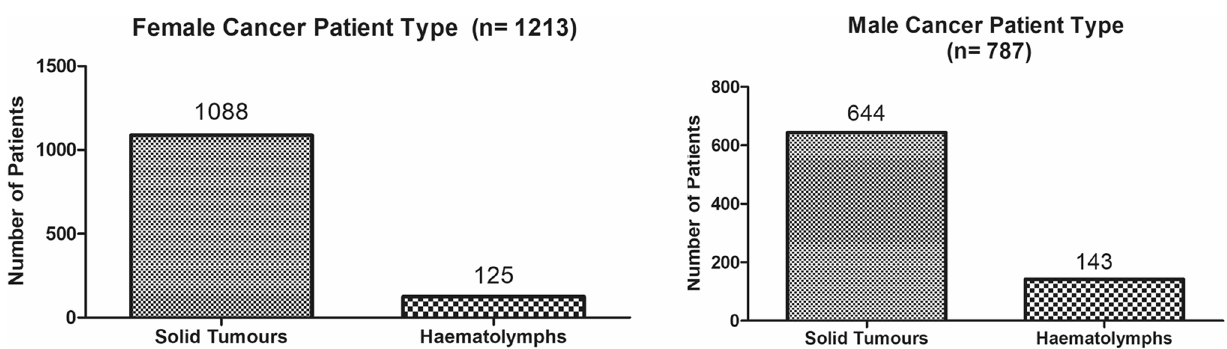
Figure 3. Graph showing age wise distribution of male cancer patients (ANOVA-Dunnett’s Test, P < 0.05).